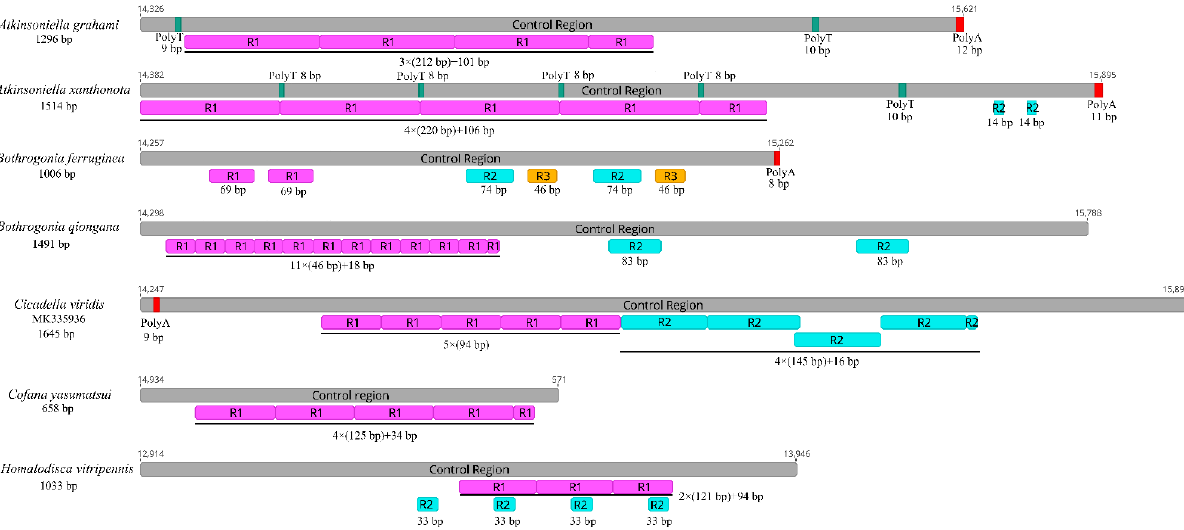
Figure 6. Organization of the control regions in the mitochondrial genomes of Atkinsoniella graham , Atkinsoniella xanthonota, and the five other Cicadellinae species. The gray blocks refer to the control region. The numbers located at the start and end of gray blocks refer to the location of control region in each mitogenome. R refers to repeat unit, with the number indicating the number of repeats. The red and green blocks refer to the structures of poly (A) and poly (T), respectively.